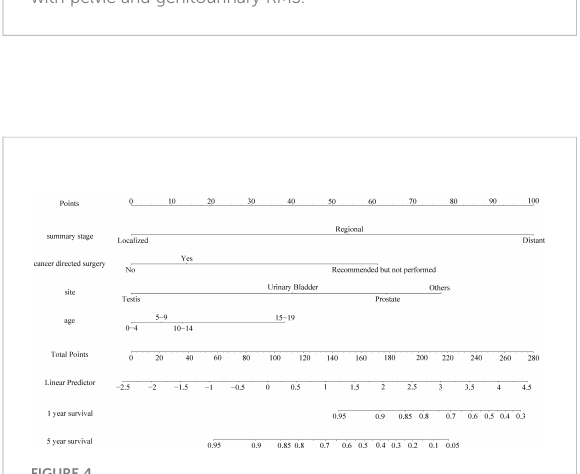
FIGURE 3 The nomogram of predicting OS of patients aged 0-19 years with pelvic and genitourinary